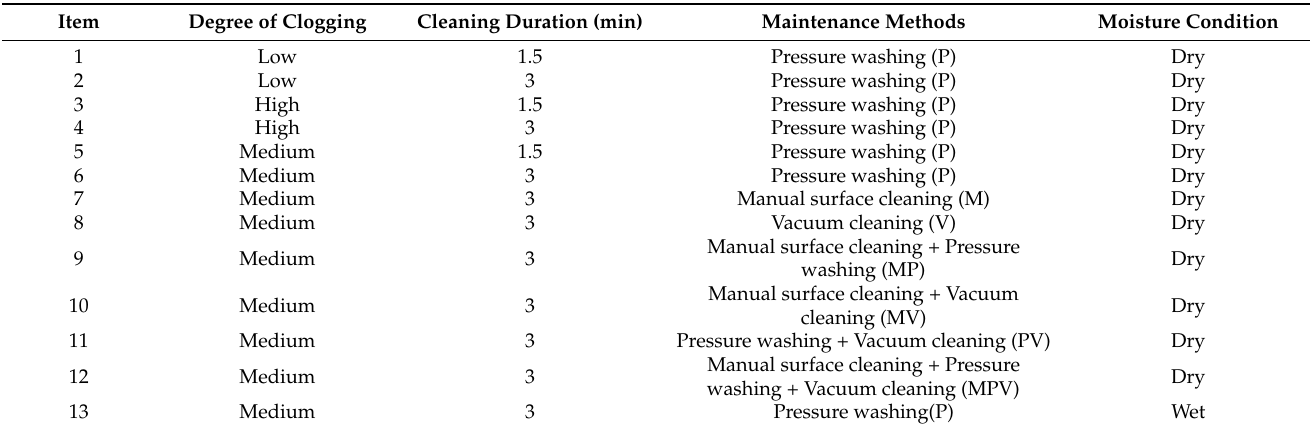
Table 2. Experimental scheme of